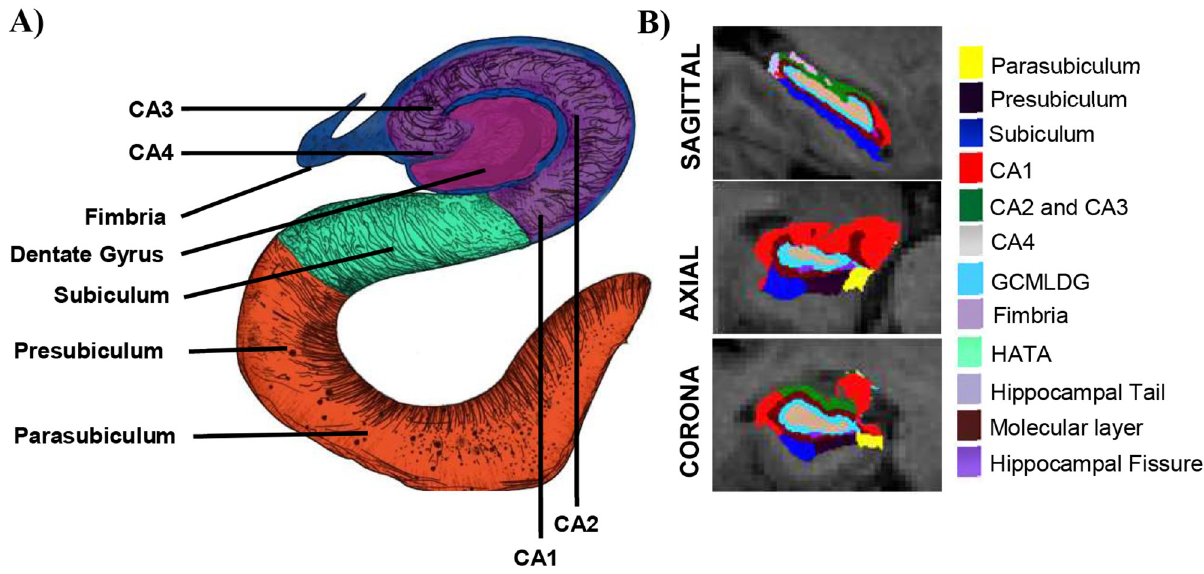
Fig 1. Hippocampal subfields as segmented using the Freesurfer. A) A transverse section of hippocampus displaying the different regions of the hippocampus, B) An illustration of the heterogenous hippocampus segmented into 12 subfields using an automated segmentation technique used in this study based on an atlas developed using Bayesian inference algorithm. CA—cornu ammonis, GCMLDG—granule cell layer of the dentate gyrus, HATA—hippocampus-amygdala-transition